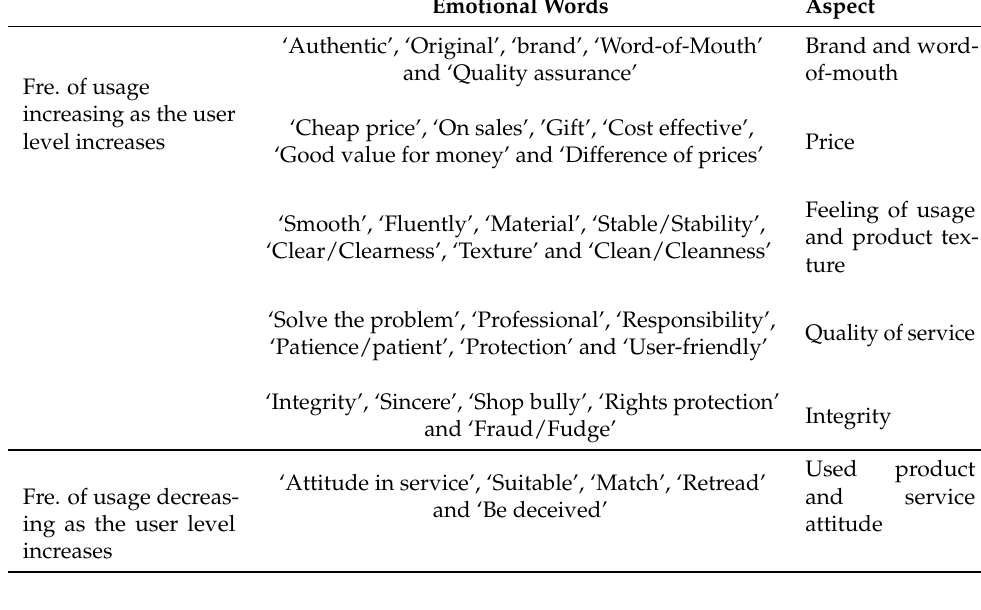
Table 3. Emotional words with different trends as the user level